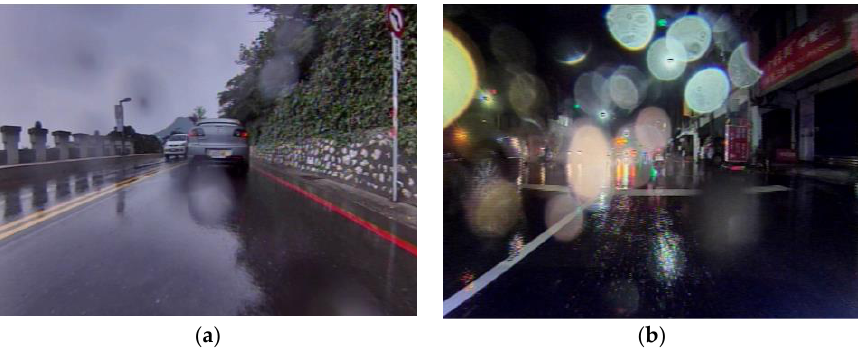
Figure 13. Nighttime scenarios: ( a ) brake light, ( b ) headlight reflection, and ( c ) poor lighting.